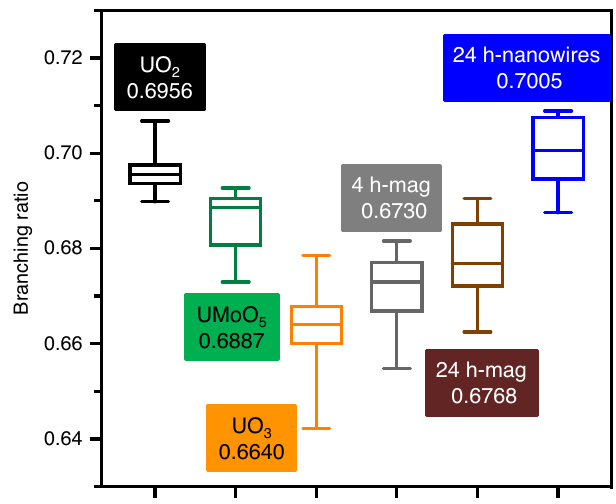
Fig. 7 Branching ratios from electron energy-loss spectroscopy. The measurements were obtained in TEM mode. UO 2 , UMoO 5 , and UO 3 were measured as the reference samples for U(IV), U(V), and U(VI) valence states. The samples considered are: the magnetite surface at various locations for the samples equilibrated for 4 h (4 h-mag) and 24 h (24 h- mag), or U nanowires in the 24-h sample (24 h-nanowires). The results are plotted based on 10 – 13 measurements for each standard or sample. In the box-and-whisker plot, the box represents the median and the 25th and 75th percentile, while the whiskers extend from the minimum to the maximum value. Source data are provided as a Source Data fi